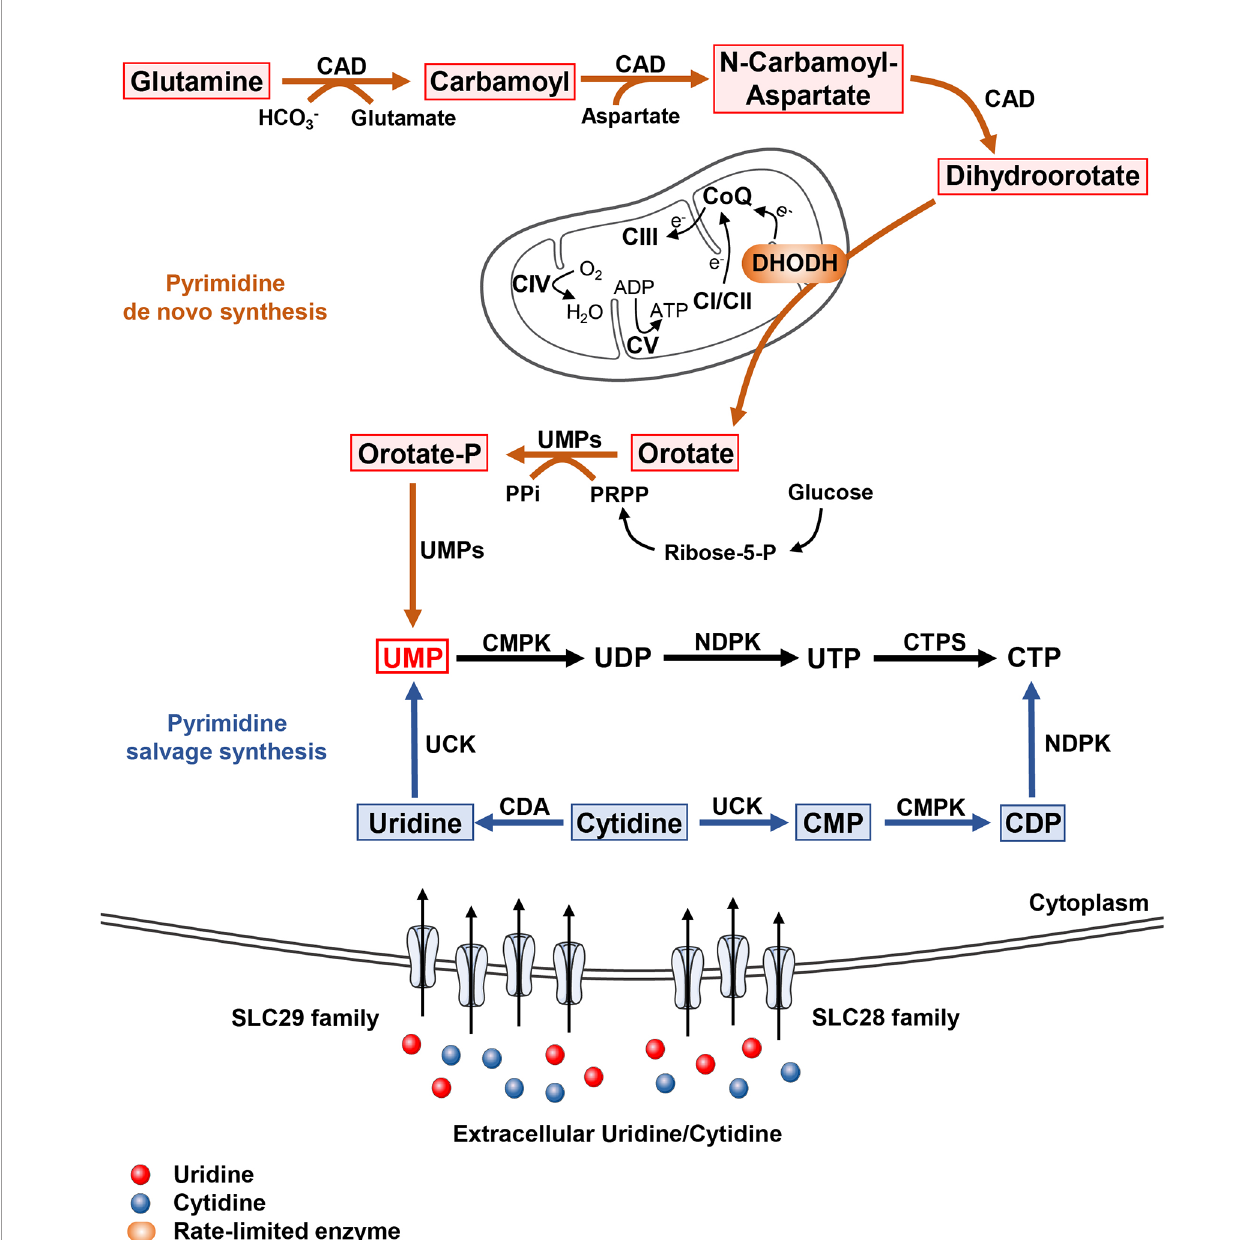
FIGURE 1 | The pyrimidine metabolism in cells In mammal, pyrimidine synthesis is composed of de novo pathway and salvage pathway. The de novo synthesis pathway initiated with the generation from glutamine to dihydroorotate catalyzed by trifunctional enzyme CAD including carbamoyl-phosphate synthetase, aspartate transcarbamylase, and dihydroorotase. The mitochondrial inner membrane protein DHODH oxidizes dihydroorotase to orotate accompanied by the respiratory chain transmission. Orotate is subsequently phosphorylated and produced to UMP by bifunctional enzyme UMPs. As for pyrimidine salvage synthesis pathway, cells obtained extracellular uridine and cytidine mainly through two nucleosides transporter families, SLC28A as well as SLC29A. Subsequently, uridine and cytidine are converted to UMP and CTP,